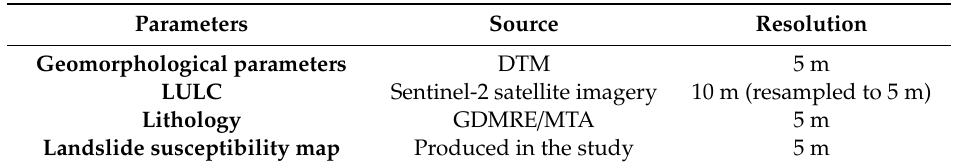
Table 1. Properties of input parameters. LULC—land use and land cover; DTM—digital terrain model; GDMRE / MTA—General Directorate of Mineral Research and